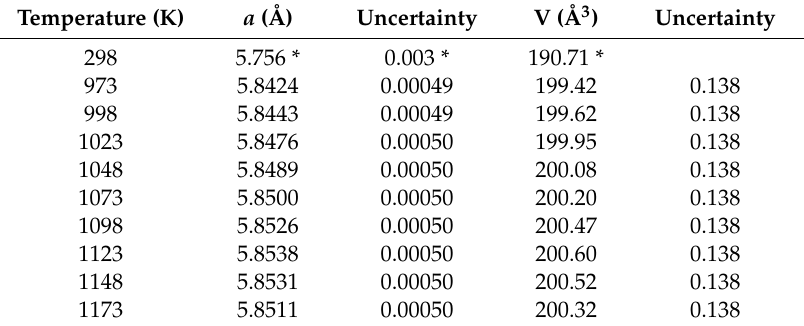
Table 3. Measured lattice parameters and volumes for α -LaOF from 973 K to 1173